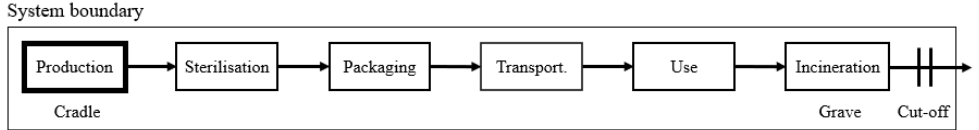
Figure 2. Virgin catheter product system. The life stages are arranged in a linear life cycle from cradle- to-grave, which here is defined as production to incineration. We follow the cut-off system that is marked by the square system